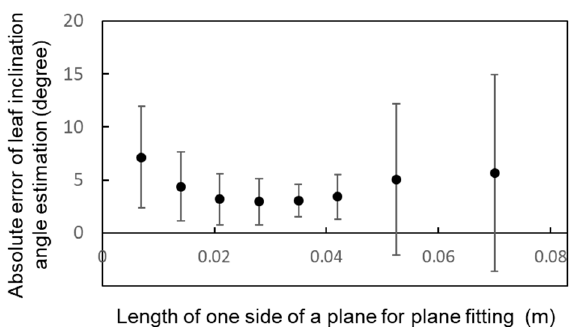
Figure 5. Relationship between length of one side of plane for plane fitting and absolute error of leaf inclination angle estimation.